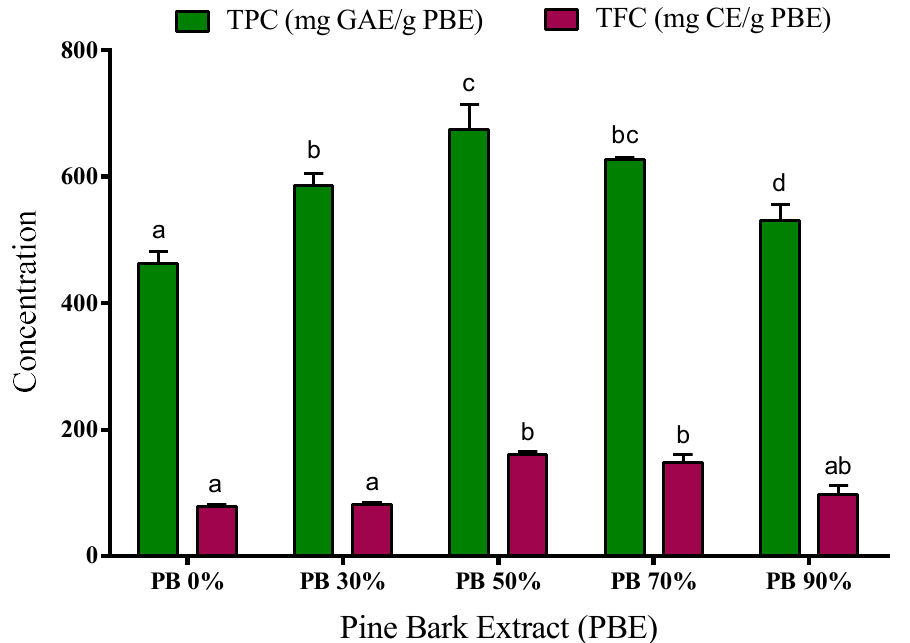
Figure 1. Total phenolic content (TPC) and total flavonoid content (TFC) of aqueous and hydroethanolic extracts from Pinus pinaster bark. Values are expressed as mean ± SD of 3–4 experiments; GAE: gallic acid equivalents; CE: catechin equivalents. Different letters show significant differences ( p < 0.05) between groups for the same experiment.